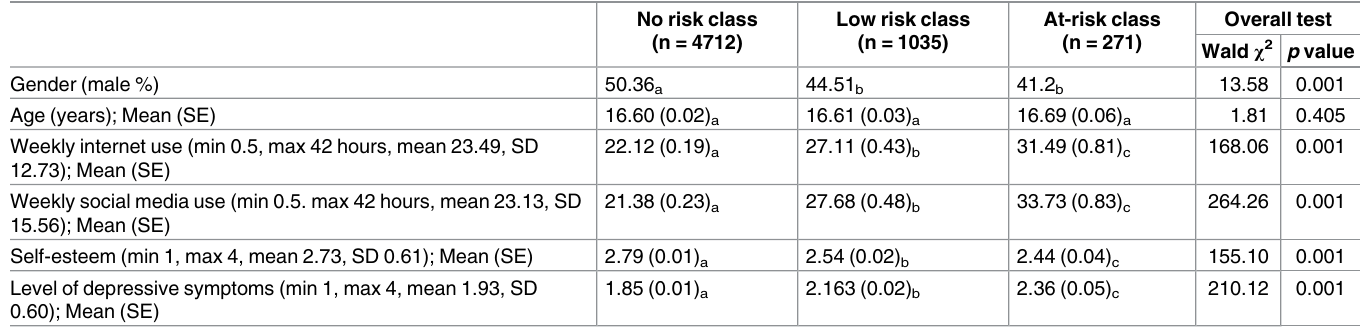
Note : Different subscript letters (a, b, c) in the same row reflect significant ( p < 0.05) difference between the means while same subscript letters in one row reflect non-significant difference between the means according to pair wised Wald χ 2 test of mean equality for latent class predictors in mixture modeling